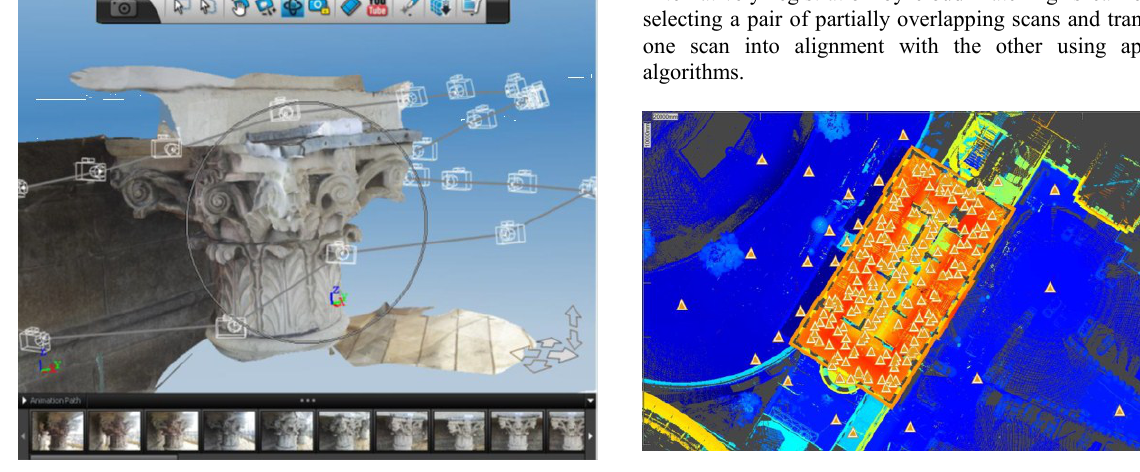
Figure 7: 3D photogrammetric model of Gallarus Oratory